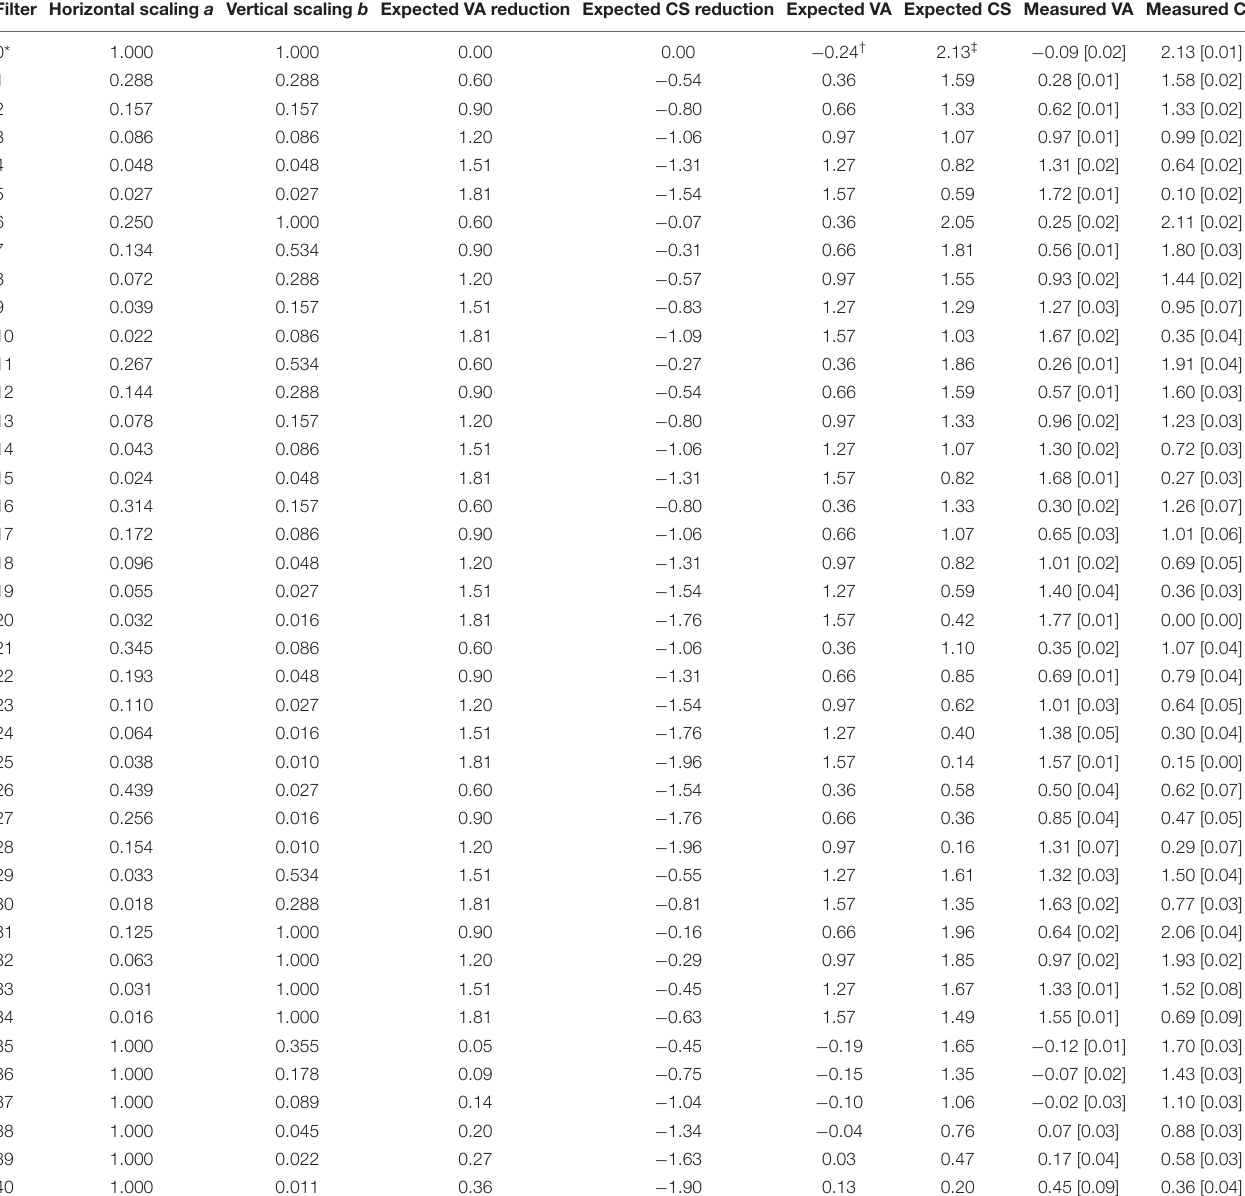
TABLE 1 | Simulated low-vision conditions: scaling factors (a and b), expected VA and CS Reductions, expected VA and CS values, and measured VA and CS values (mean [standard deviation]) in the normally sighted young